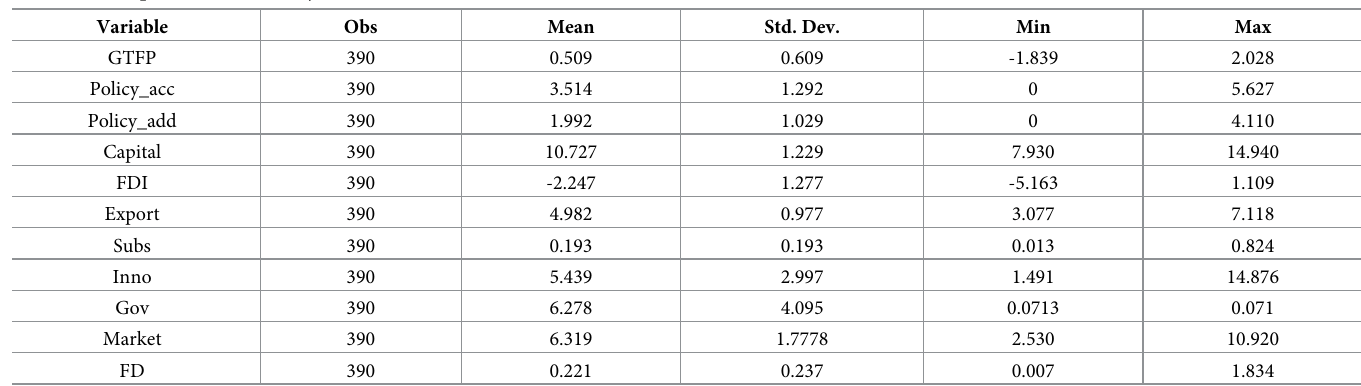
Table 1. Descriptive statistics of major